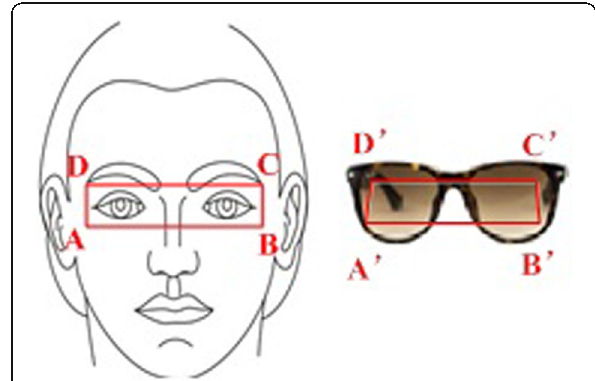
Fig. 20 The quadrilateral made on face and eyeglass